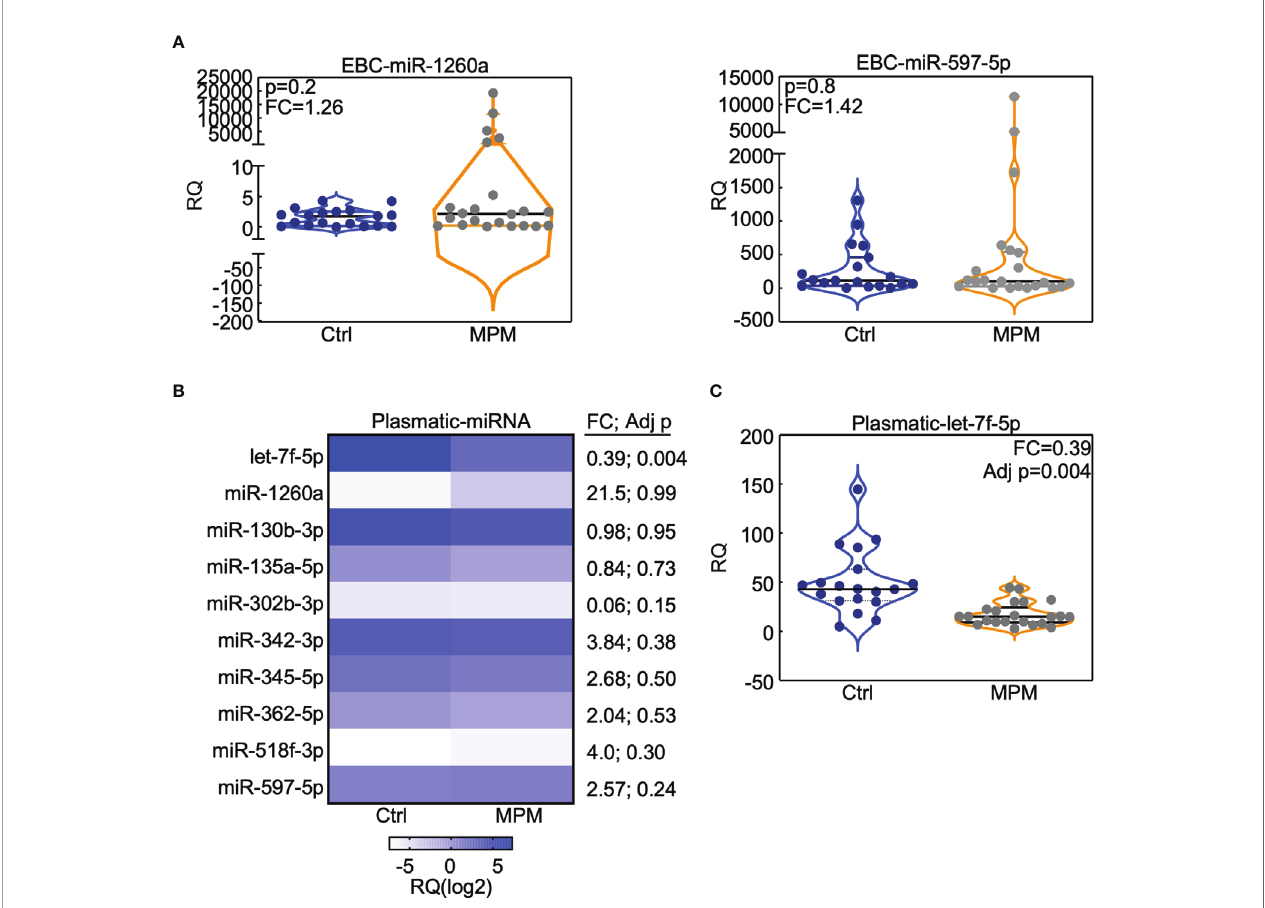
FIGURE 4 | miRNAs analysis in the MPM cohort. The indicated miRNAs were analyzed in the EBC (A) or in the plasma (B, C) obtained from 23 MPMs and 19 cancer-free subjects who were previously exposed to asbestos (Ctrl). (B) Heatmap (generated with GraphPad Prism software) indicates the expression level of the indicated plasmatic miRNA in MPM or control subjects. (A, C) Data are presented with violin plots where each case is a dot and lines indicate median with interquartile range. RQ, Relative quantity; FC, fold change; Adj p, FDR-adjusted p